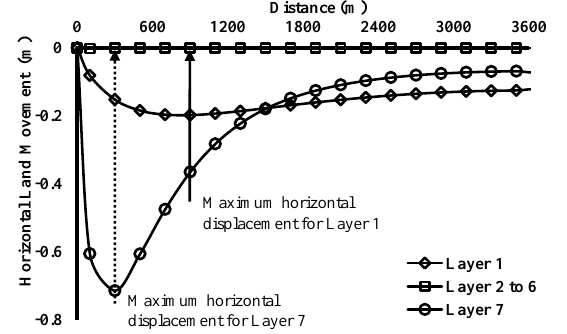
Figure 3. Horizontal subsidence after 100 day pumping simulated by NDIS.